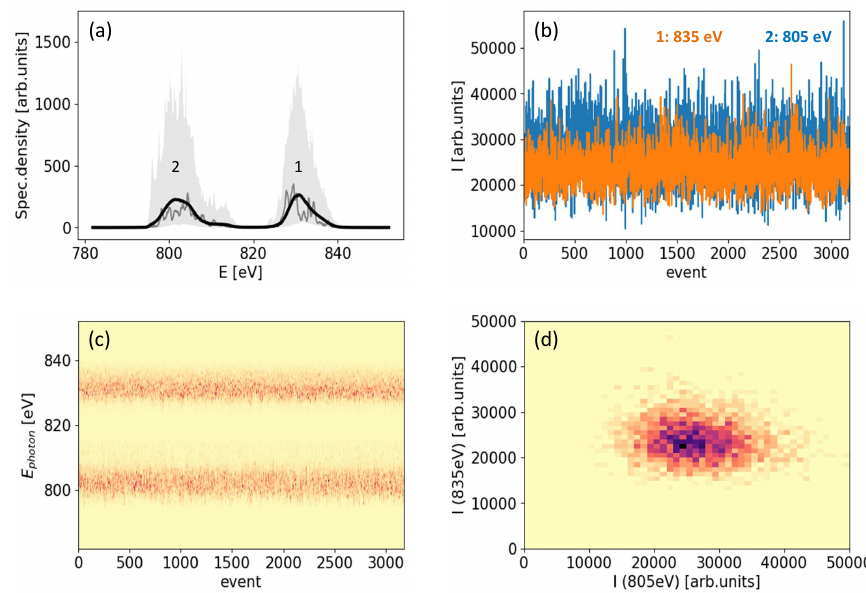
Figure 12. Experimental demonstration of two-color lasing: ( a ) single shot spectral distribution measured with grating spectrometer (grey line) and average over 3100 consecutive events (black line). The light grey area shows the span of spectral densities in the ensemble; the 835 eV pulses were emitted in U1, and the 805 eV pulses in U2, as indicated with numbers “1” and “2”; ( b ) integrals under the spectra for both colors over time; ( c ) positions of the spectra over time; ( d ) correlation between the two integrals depicted on subfigure ( c ).